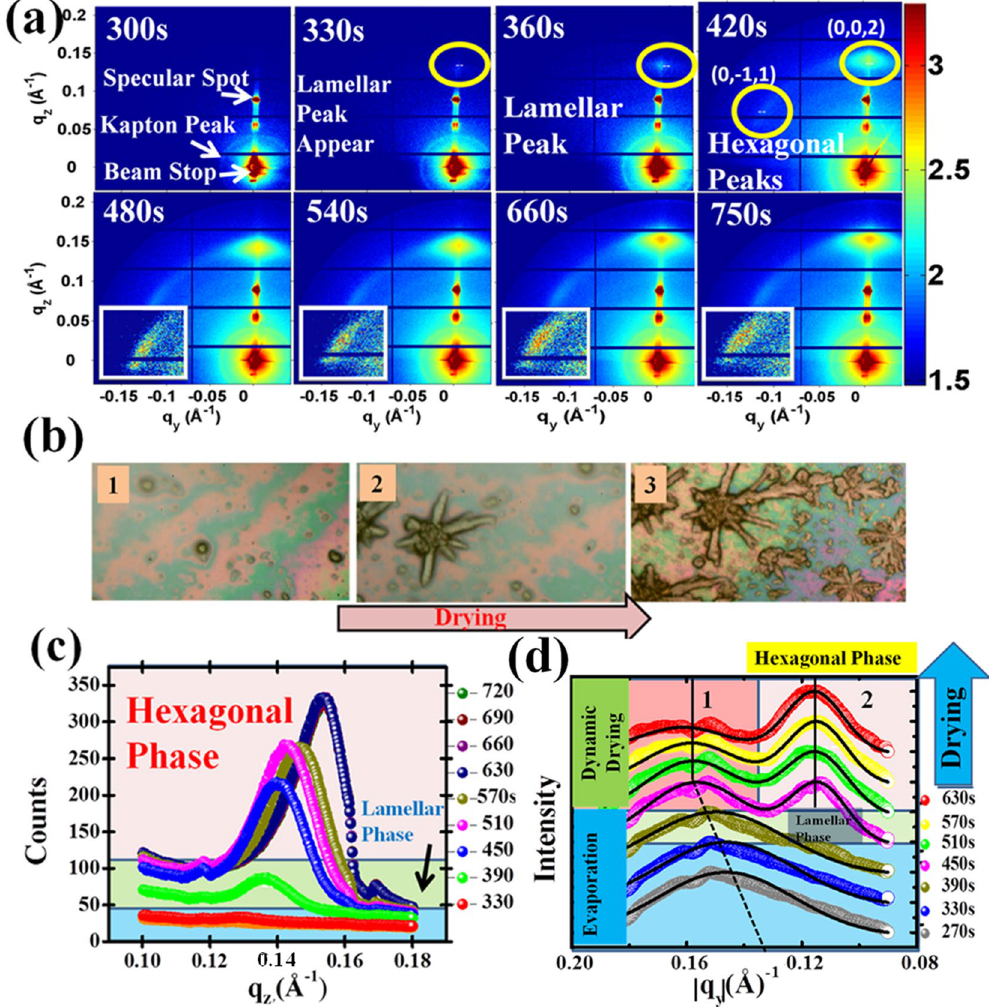
Figure 5. The evolution of DMV-CS nanofibers in the solution as a function of time during drying. ( a ) The representative data reveals three distinct regions, for initial 300 s no ordered structure was observed, then from 330 s to 360 s a single spot in the q z direction was observed indicating formation of a lamellar structure. After 450 s distorted hexagonal structures appear in the drying solution as the (0, 0, 2) and (0, − 1, 1) (refer insets for magnified scale) diffraction spots appear. Further evaporation results in the increase in the distortion of the lattice as the water content in the solution decreases. ( b ) The optical microscopy images are shown at three representative stages of the drying process, namely (1) the initial condition when the nanofiber dispersion was deposited on the substrate, (2) the beginning of the formation of structures and (3) the final assembled structure of the nanofibers. ( c ) and ( d ) show the q z and the q y cuts of the 2D GISAXS data respectively where transition from lamellar to hexagonal phase is apparent in both q z and q y cuts. The q y data also elucidate the evolution of the lamellar phase – the shift in the position of this peak is